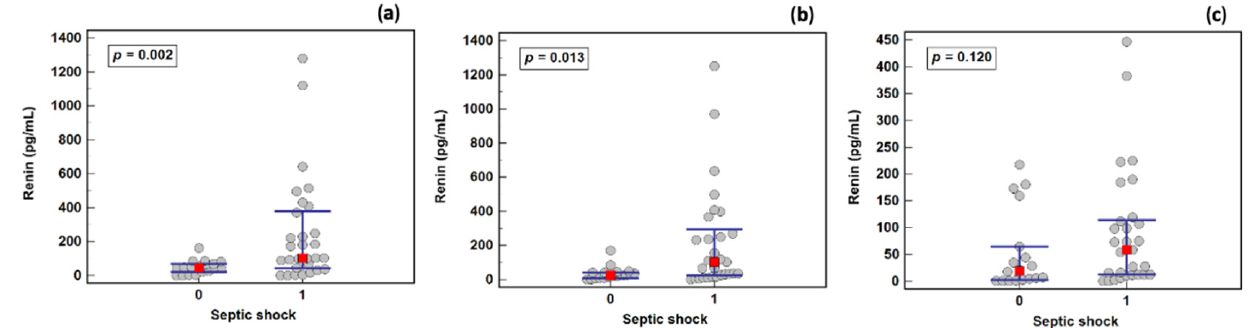
Figure 4. The effect of septic shock on renin concentration: ( a ) on the first study day; ( b ) on the third study day; ( c ) on the fifth study day. Legend: 0—sepsis group, 1—septic shock group. Notes: Data were analyzed using Mann– Whitney U tests, and are presented as medians (red squares) with interquartile ranges (blue whiskers).